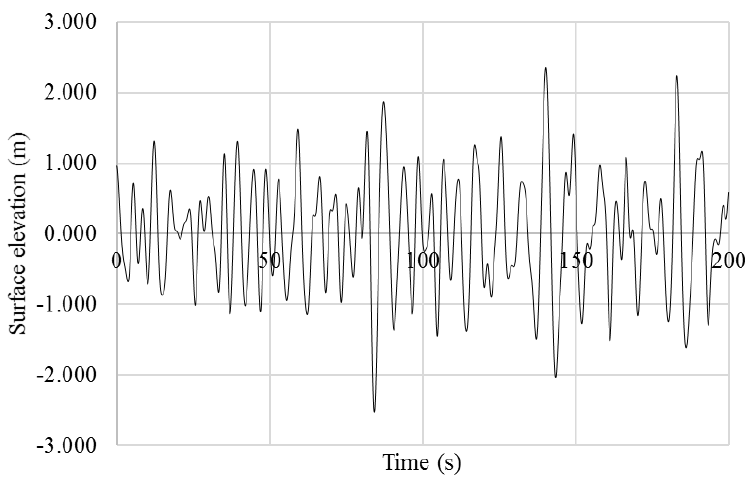
Figure 15. A wave surface elevation simulation.